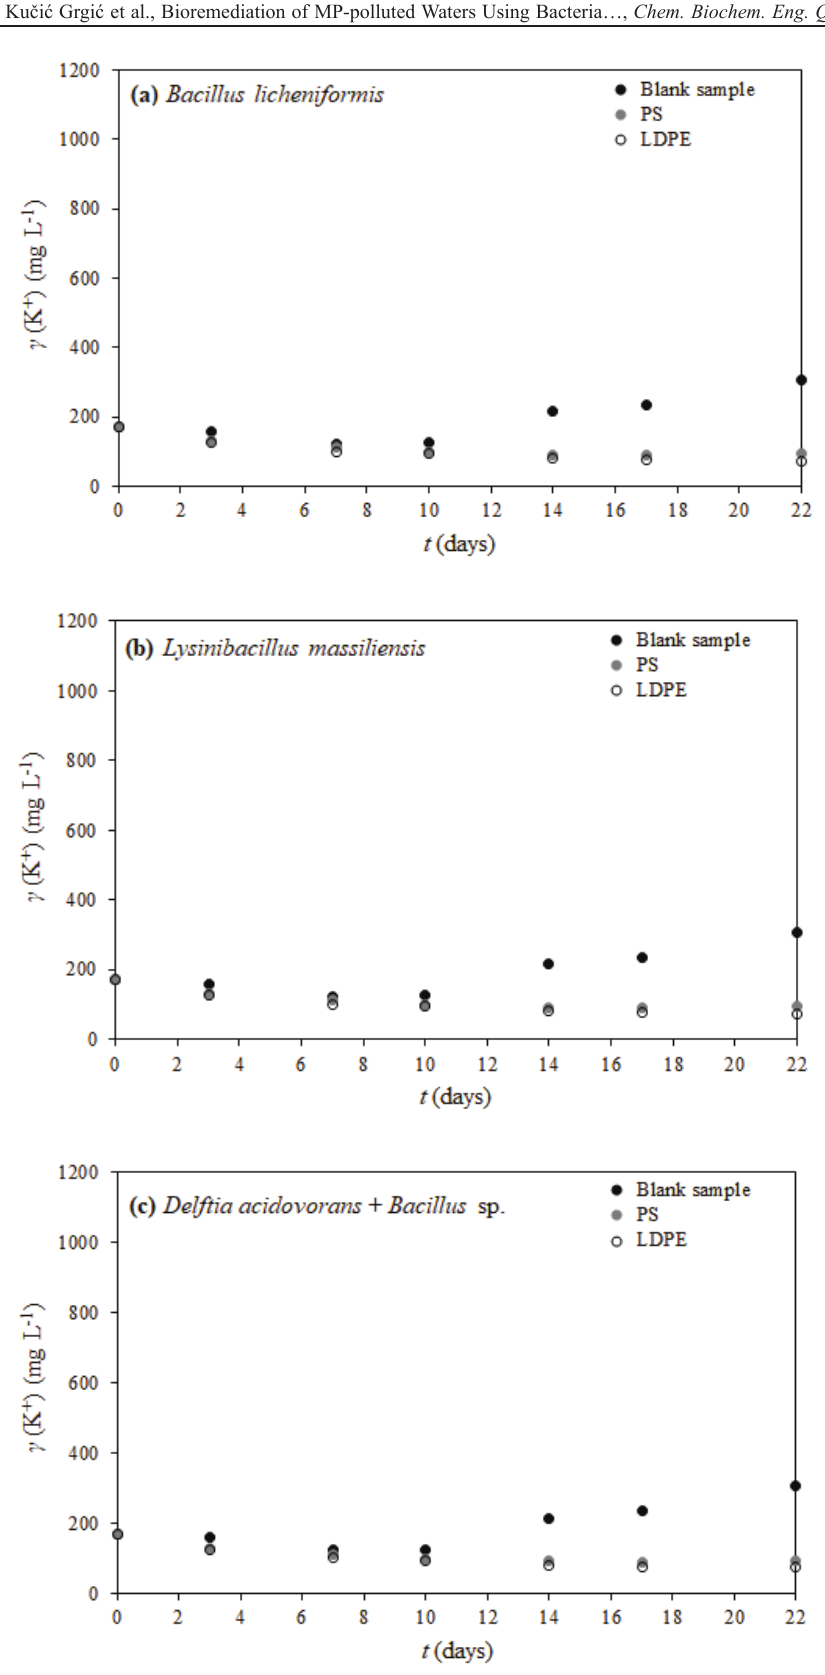
Fig. 9 – Changes in potassium concentration during biodegradation of MP-LDPE and MP-PS with bacterial culture Bacillus li- cheniformis (a), Lysinibacillus massiliensis (b), and mixed bacterial culture of Bacillus sp. and Delftia acidovorans (c) in sterile Erlenmeyer flasks during 22 days (Vr = 100